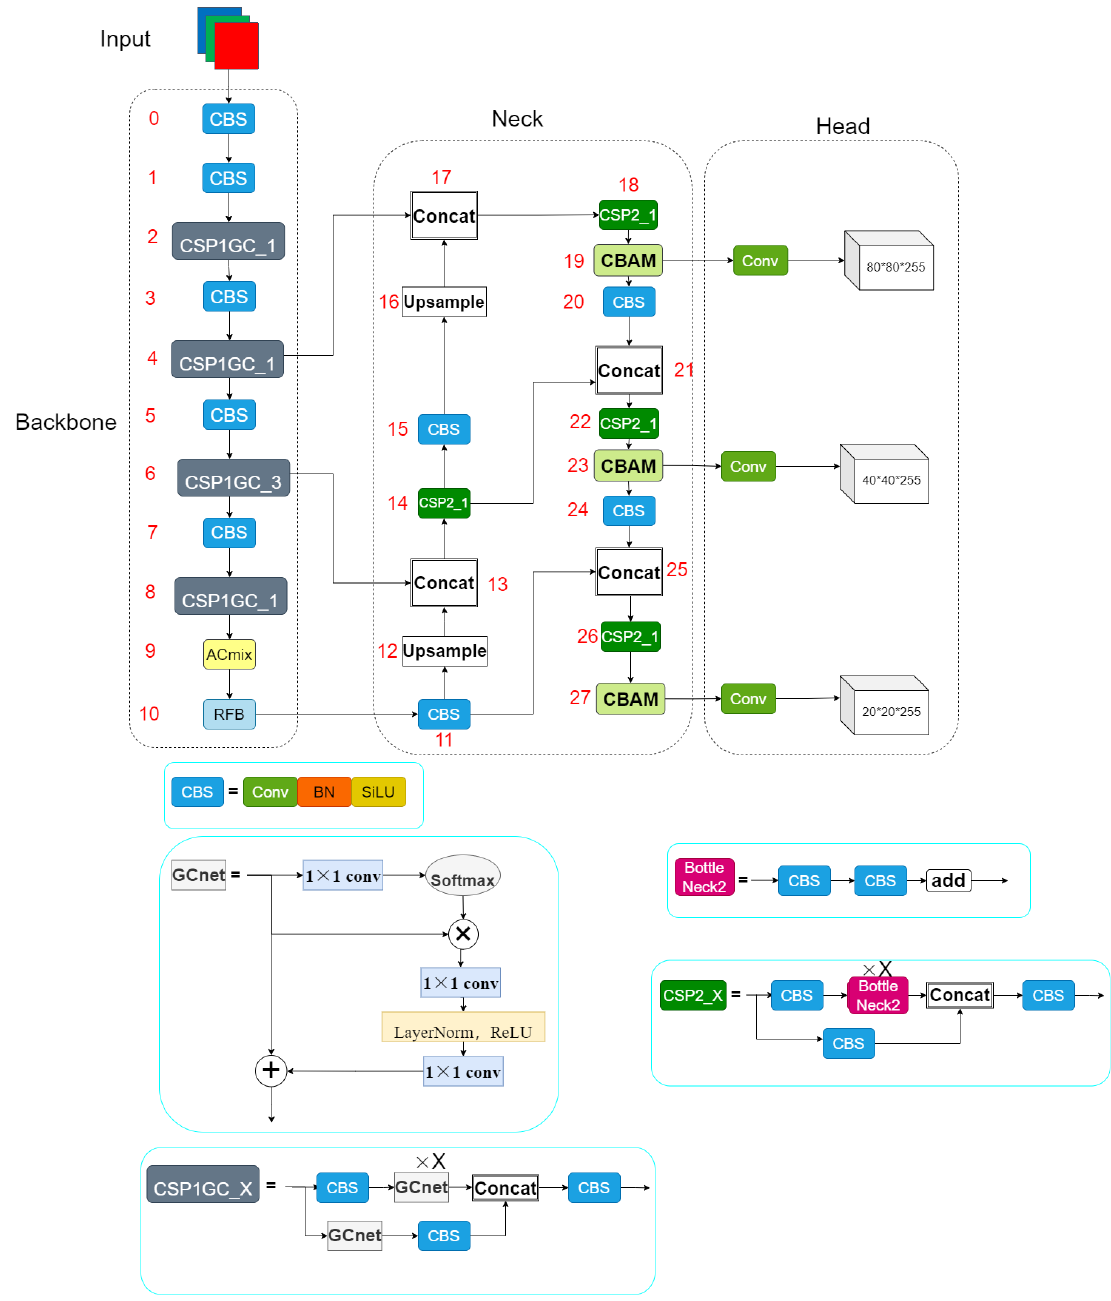
Figure 7. The structure of YOLO-Tea.